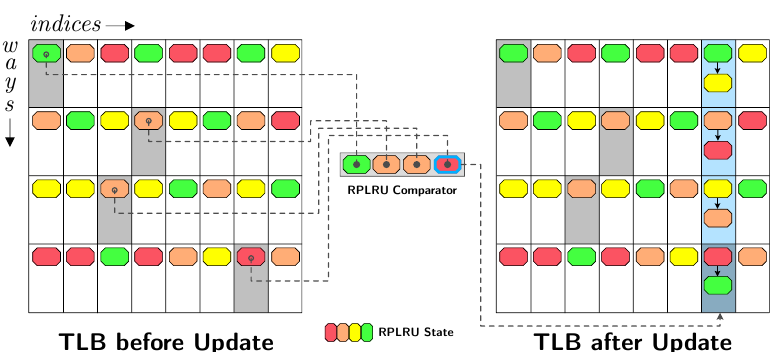
Figure 3: Overview of the Randomized-Pseudo-Least-Recently-Used replacement policy.